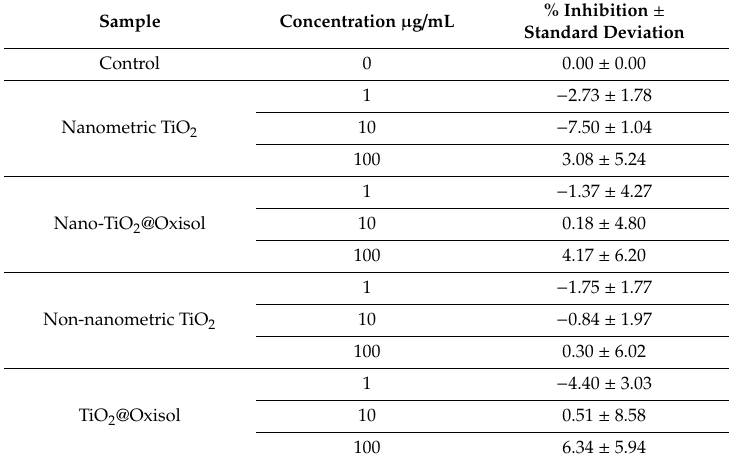
Table 9. Cytotoxicity values (cell growth inhibition) obtained evaluating di ff erent concentration of powders (1,10,100 µ g /